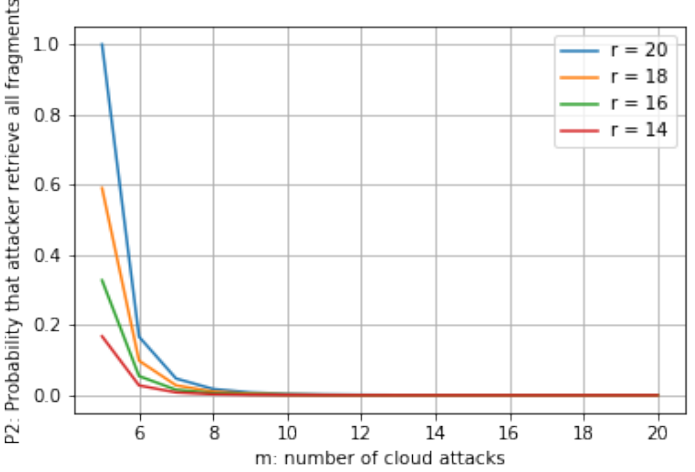
Figure 7. Probability that attaker retrive all fragments in condition storage path is